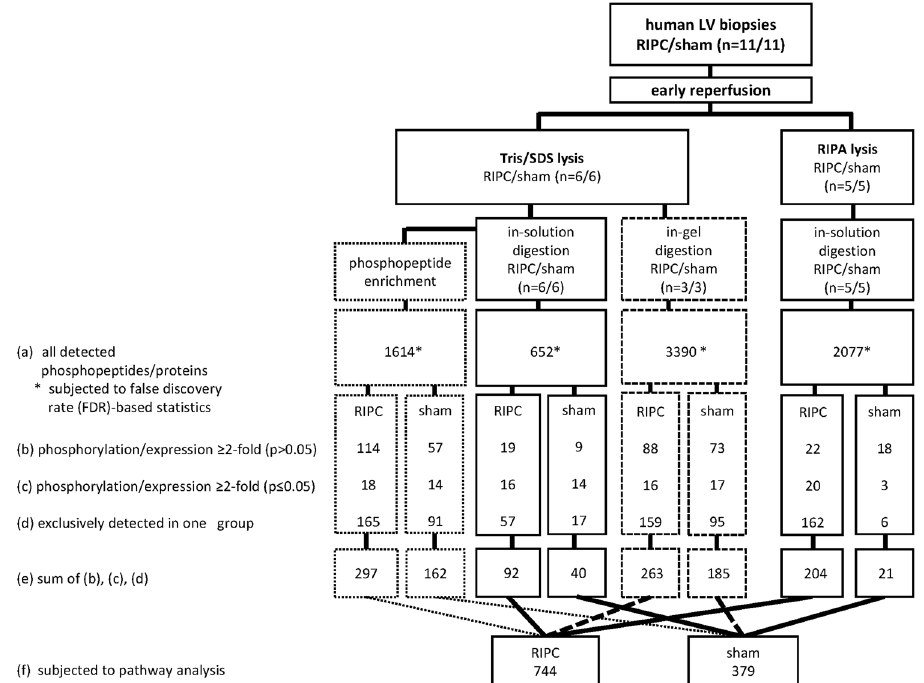
Figure 3. Flow chart of sampling and proteome analysis of human left ventricular biopsies. Human left ventricular (LV) biopsies from patients without (sham) or with remote ischemic preconditioning (RIPC) were lysed in Tris/sodium dodecyl sulfate (Tris/SDS) or in radioimmunoprecipitation assay (RIPA) buffer. Proteome analysis was performed after phosphopeptide enrichment, in-solution digestion, and in-gel digestion with Tris/SDS buffer-lysed biopsies and after in-solution digestion with RIPA buffer-lysed biopsies, respectively. The numbers of all detected phosphopeptides/proteins were displayed in line (a), those with ≥ 2-fold higher phosphorylation/expression in line (b) and with significant (p < 0.05) ≥ 2-fold higher phosphorylation/expression with RIPC versus with sham in line (c), as well as those exclusively detected with RIPC or with sham in line (d). The sum of line (b), (c) and (d) was displayed in line (e). All detected phosphopeptides/proteins (line (a)) were subjected to false discovery rate (FDR)-based statistical analysis. Independently of lysis and digestion methods, all proteins detected with a ≥ 2-fold higher phosphorylation/expression with RIPC versus with sham and those exclusively detected in one group, respectively, were considered (line (f)) for an in-silico pathway